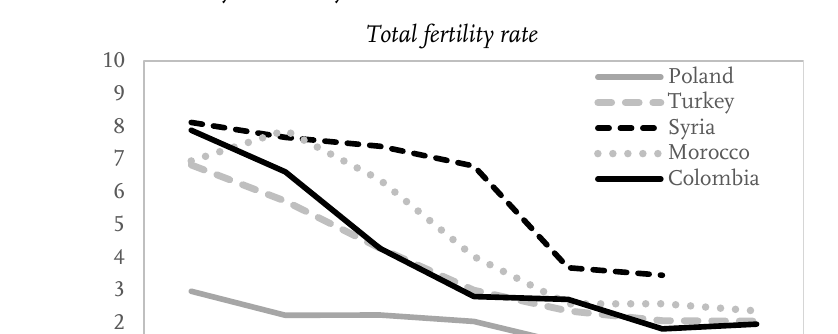
Labour force participation